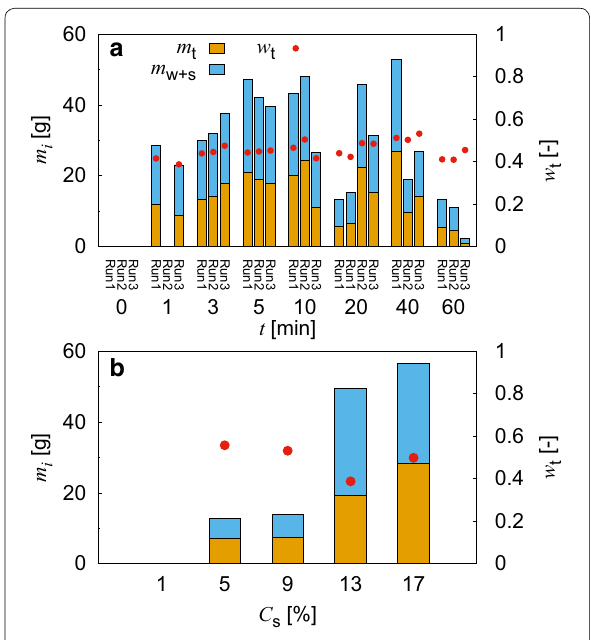
Fig. 10 Composition of aggregates produced in EXP1–2. Mass composition, m i , and mass fraction of tephra, w t , in aggregates: a effect of rotation time, t (EXP1: d t = 32 – 63 µ m , C t = 33% , and C s = 9% ) and b effect of snow concentration, C s (EXP2: d t = 32 – 63 µ m , C t = 33% , and t = 20min ). Yellow and aqua bars denote the mass of tephra and water plus snow, m t and m w+s , respectively